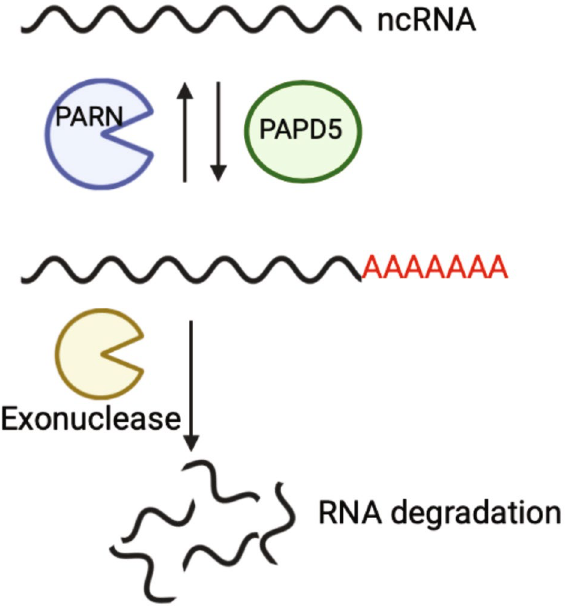
Figure 1. PARN functions in an adenylation/deadenylation regulatory pathway that regulates the decay rate of ncRNAs. ncRNAs could be targeted to adenylation by PAPD5 or deadenylation by PARN 8 . In PARN-deficient cells, the presence of oligo(A) tail can recruit 3 ′ to 5 ′ exonucleases to degrade